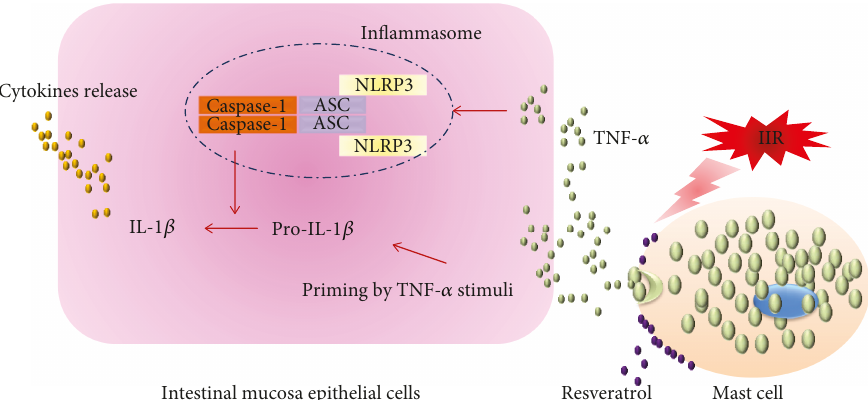
Figure 5: Resveratrol reduces intestinal ischemia-reperfusion injury by inhibiting mast cell-related NLRP3 in fl ammasome activation. Under intestinal ischemia-reperfusion conditions, mast cells are activated and degranulated. Cytokine TNF- α was released following mast cells activation, resulting in NLRP3-related in fl ammasome activation and subsequent IL-1 β generation. Amount of proin fl ammatory cytokines produced and released from intestinal mucosa epithelial cells. Resveratrol pretreatment prevented the mast cells from degranulation via stabilizing mast cell membrane, which inhibited intestinal mucosa epithelial cell NLRP3-related in fl ammasome